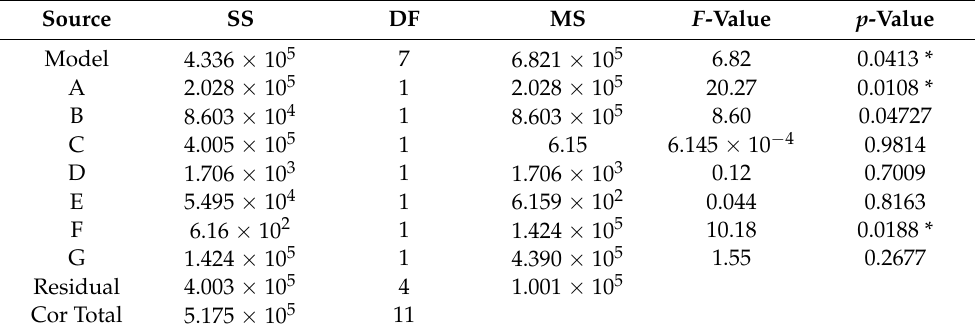
Table 3. Signification analysis of the PB experiments on balanol production.